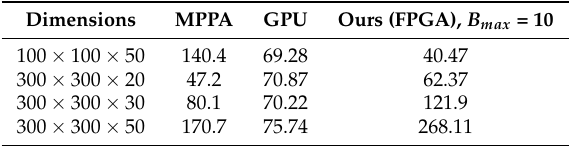
Figure 18. Comparison of different hardware platforms between latency per pixel, power consumption, input size (bands) and energy. Table 6. Execution time (ms) for the PCA implementation on GPU, Massively Parallel Processing Array (MPPA), and FPGA (our work). The first two designs on GPU and MPPA are from